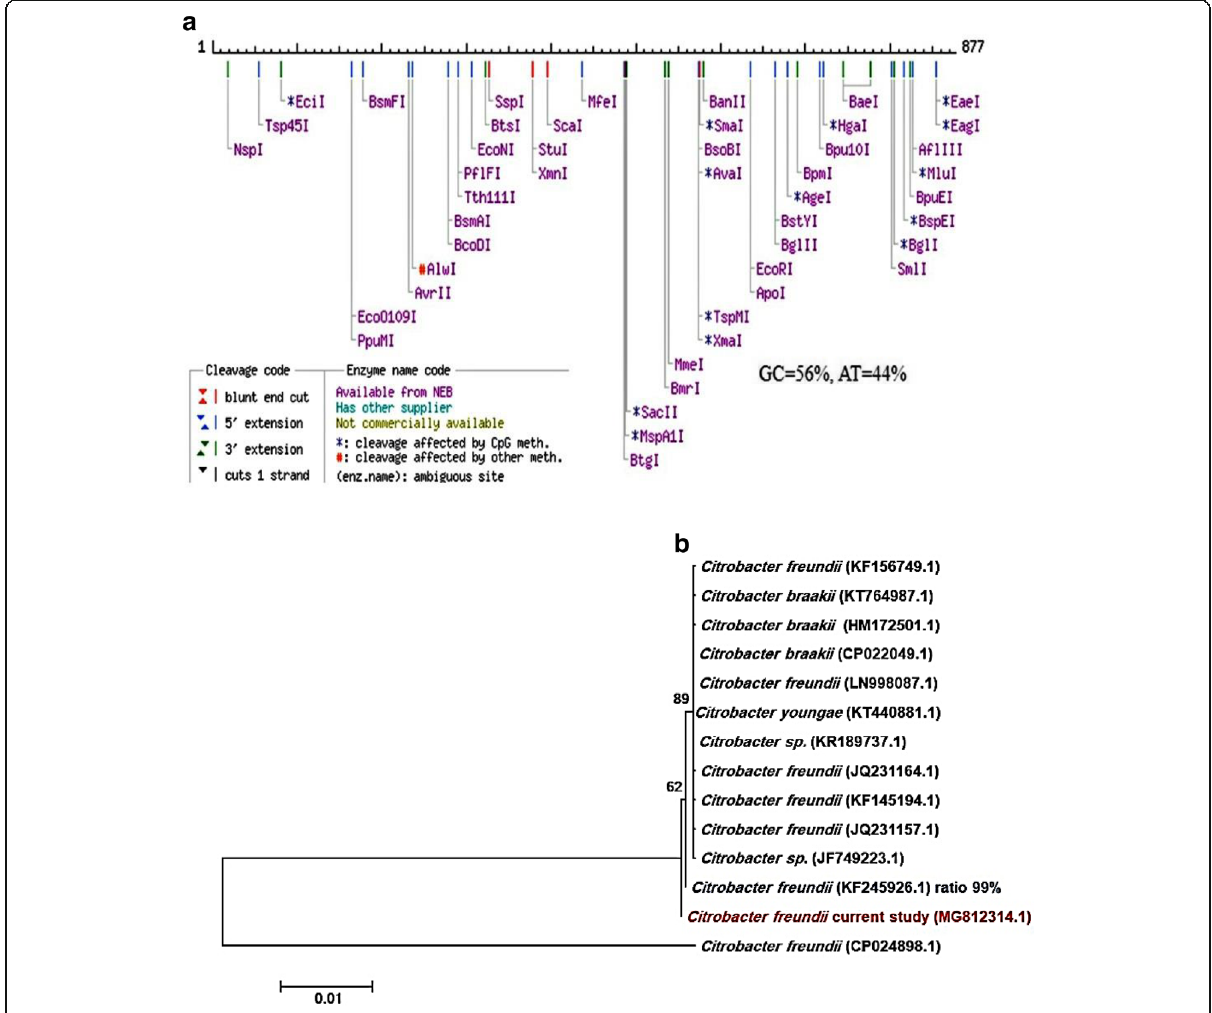
Fig. 5 a Restriction map of the partial sequence of 16S rRNA gene of interest with available commercially restriction enzymes. b Phylogenetic tree showing interrelationships of isolate (BS37) based on 16S rRNA sequences